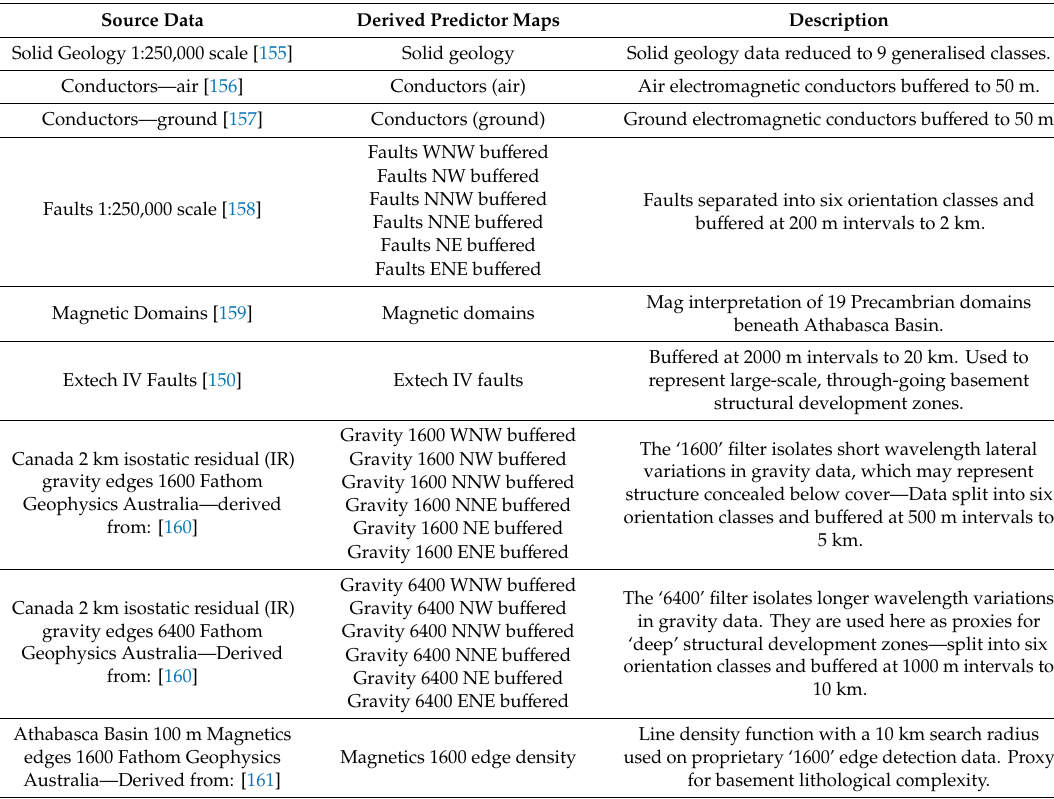
Table 3. Source data and predictors for the Athabasca Basin MPM. The data listed above are available from the ‘Geological Atlas of Saskatchewan’ or Natural Resources Canada’s ‘Canadian Airborne Geophysical Data